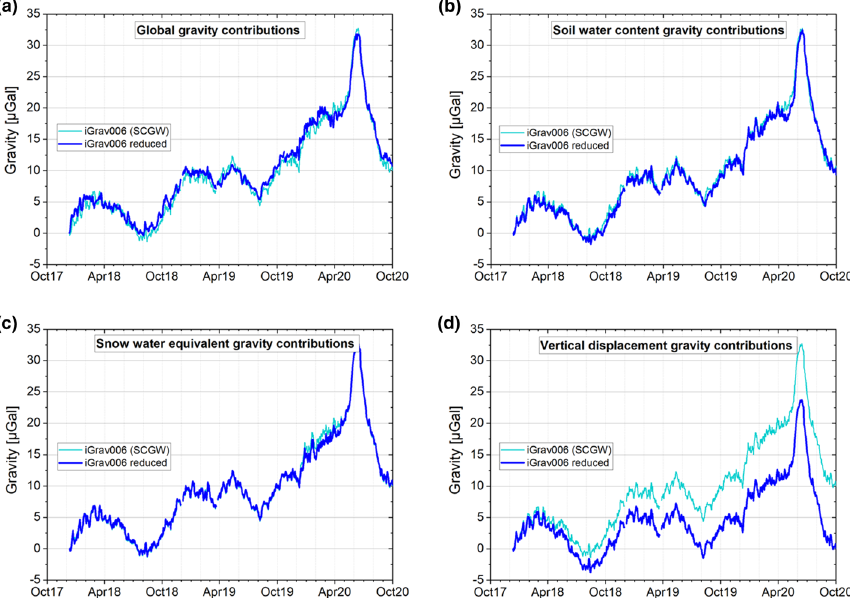
Fig. 17 Reductions of environmental gravity contributions for iGrav006 (SCGW, 3 years observation period) for a global gravity contributions; b soil water content variations; c snow water equivalent, and d vertical surface